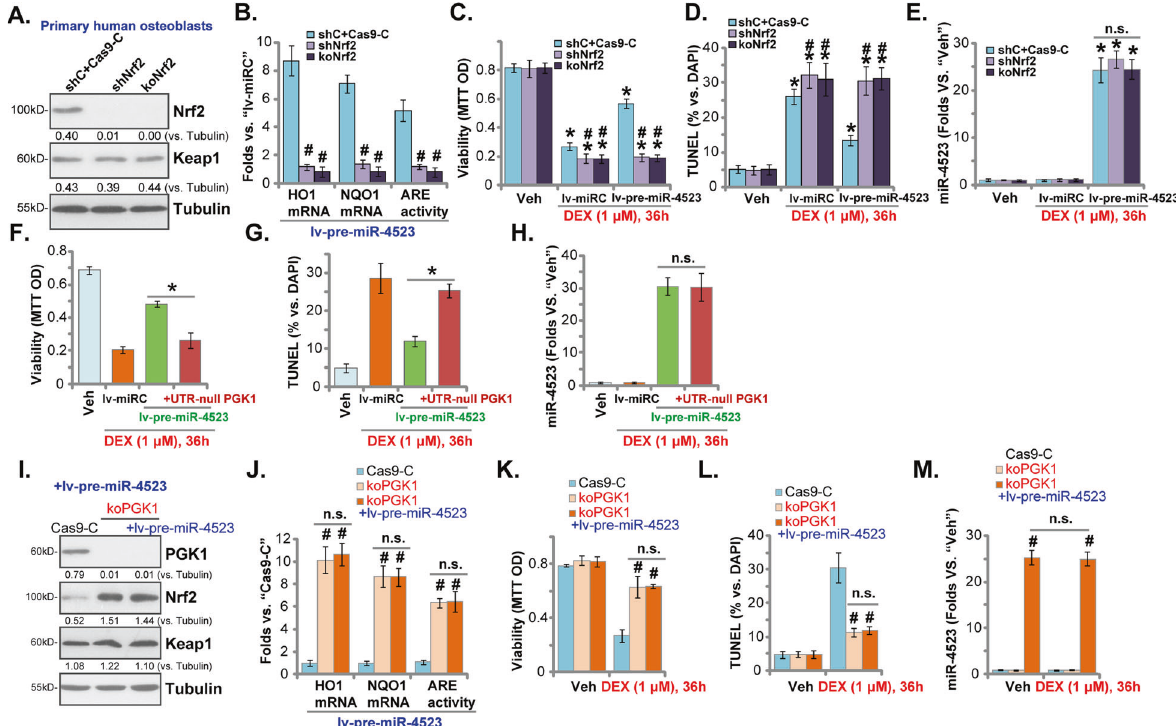
Fig. 5 miR-4523-induced osteoblast cytoprotection against DEX requires activation of PGK1-Nrf2 cascade. Stable human osteoblasts with Nrf2 shRNA (shNrf2), a CRISPR/Cas9-Nrf2-knockout construct ( “ koNrf2 ” ), or the CRISPR/Cas9 sgRNA control construct plus scramble control shRNA lentivirus ( “ shC + Cas9-C ” ) were established. These osteoblasts were further infected with pre-miR-4523-expressing lentivirus ( “ lv-pre- miR-4523 ” ), with stable osteoblasts established following puromycin selection. Expression of listed genes was tested by western blotting ( A ) and qRT-PCR ( B ) assays, with relative ARE activity examined as well ( B ). Alternatively, these osteoblasts were transduced with lv-pre-miR-4523 or the control lentiviral miR construct (lv-miRC), and treated with or without DEX (1 μ M) for applied time periods. Cell viability (MTT OD, C ), apoptosis activation (TUNEL-positive nuclei ratio, D ), and miR-4523 expression ( E ) were examined. Human osteoblasts with lv-miRC, lv-pre- miR-4523, or lv-pre-miR-4523 plus 3 ′ -UTR-depleted PGK1 construct ( “ + UTR-null PGK1 ” ) were treated with or without DEX (1 μ M) for applied time periods. Cell viability (MTT OD, F ), apoptosis activation (TUNEL-positive nuclei ratio, G ), and miR-4523 expression ( H ) were examined. Stable human osteoblasts with the CRISPR/Cas9-PGK1-knockout construct ( “ koPGK1 ” ) were further infected with or without lv-pre-miR-4523, control cells were with the CRISPR/Cas9 sgRNA control construct ( “ Cas9-C ” ). Expression of listed genes was tested by western blotting ( I ) and qRT-PCR ( J ) assays, with relative ARE activity tested as well ( J ). Cells were further treated with or without DEX (1 μ M) for applied time